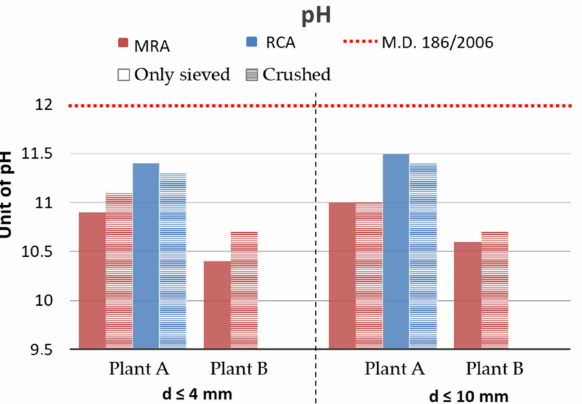
Figure 9. Trend of pH values in relation to the type of RA (RCA or MRA), particle sizes, and test conditions (i.e., material only sieved or